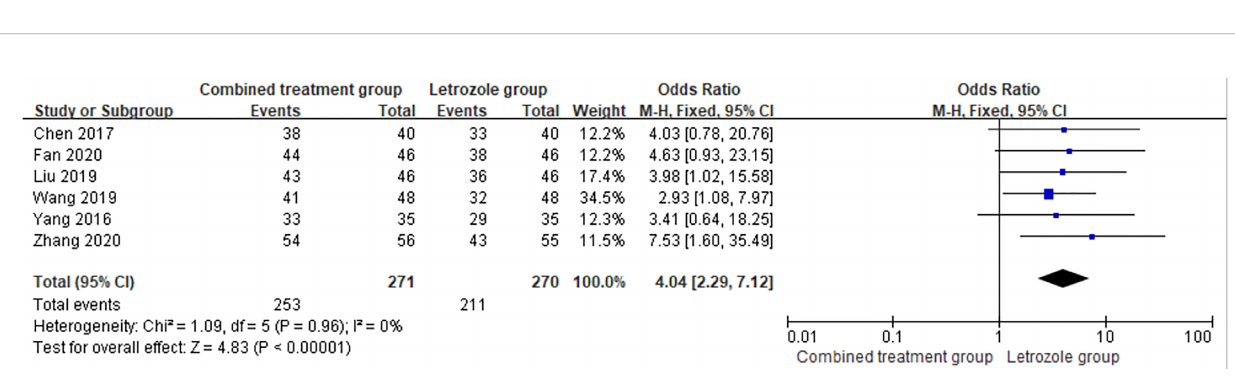
FIGURE 4 | Meta-analysis of the effect of Kuntai capsule combined with letrozole on the total effective rate in polycystic ovary syndrome (PCOS).